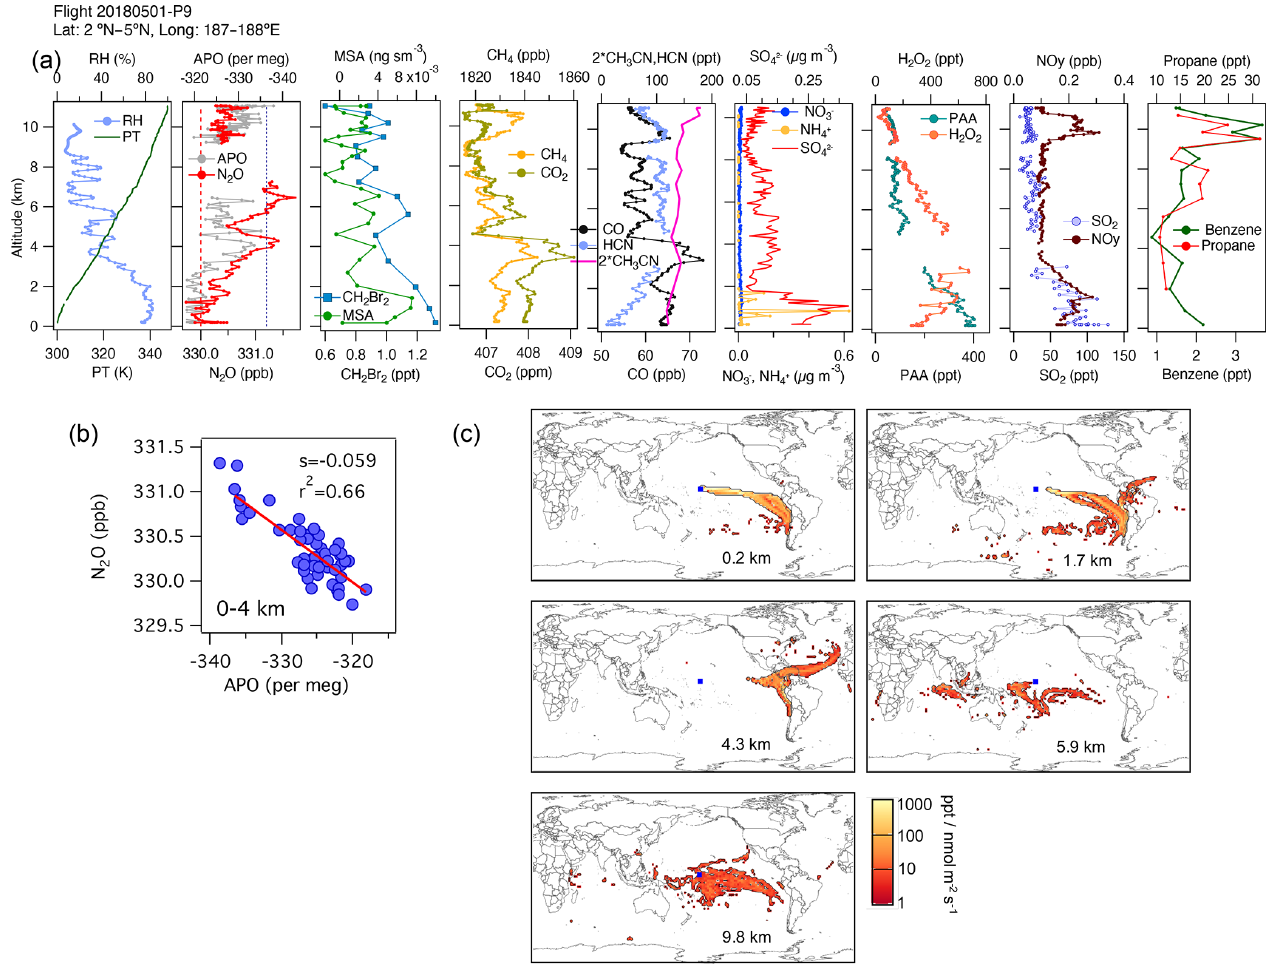
Figure 6. (a) Vertical profiles of PT, RH, and the tracers N 2 O, APO, MSA, CH 2 Br 2 , CH 4 , CO 2 , CO, HCN, CH 3 CN, NO − H 2 O 2 , PAA (CH 3 C(O)OOH), SO 2 , NO y , benzene, toluene, and propane from profile 9 on 1 May 2018. The dotted blue line in the plot of APO and N 2 O represents the NOAA-MBL reference (N 2 O-MBL) at the latitude of the flight; the dashed red line shows the N 2 O-MBL at the origin of the air masses suggested by the footprints (25 ◦ S). (b) N 2 O–APO correlations between 0 and 4km that possibly describe the latitudinal gradient of N 2 O ( s represents the slope of the linear fit). (c) Footprint maps tracing surface regions that influence mixing ratios measured in the altitude ranges 0–2, 2–4, 3–5, 5–7, and 9–11km, respectively. Blue squares show sampling locations. Values below 3pptnmol − 1 m 2 s are not included. Note that the APO axes are reversed to illustrate the negative correlation with N 2